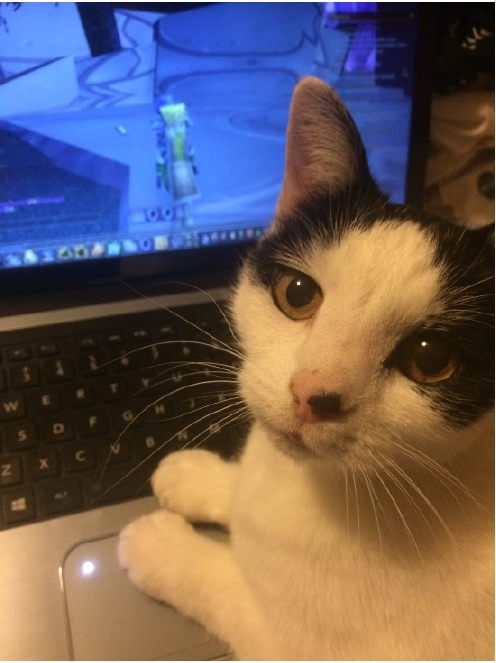
Figure 2. Symbiotic nurturing: Cat on laptop to show companionship.